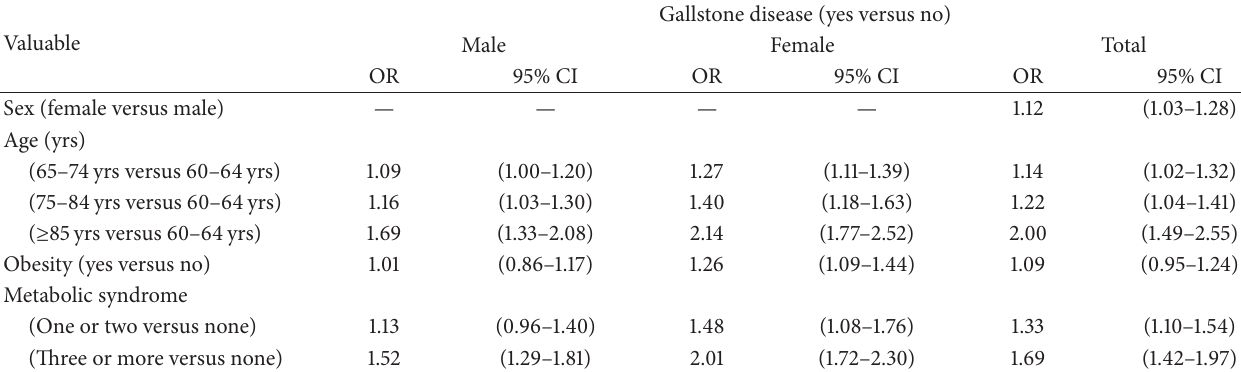
Table 3: Multiple logistic regression of association between clinical factors and gallstone disease among elderly agricultural and fishing screened subjects ( n =